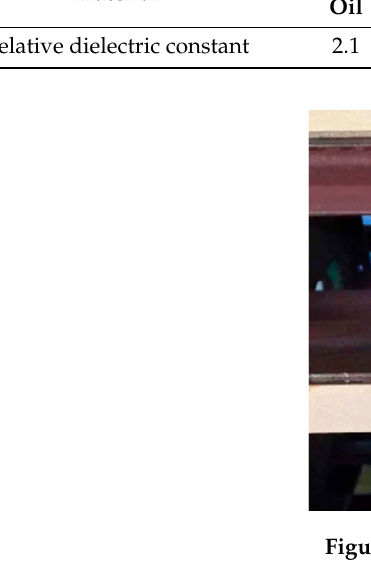
Figure 5. Transposition between cakes.